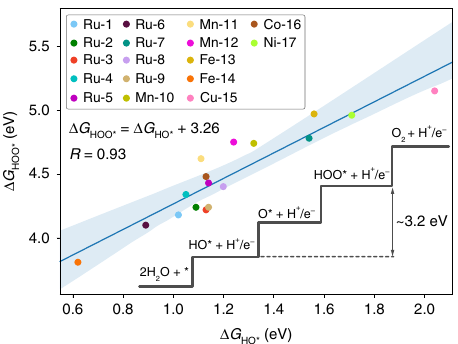
Fig. 3 Linear scaling relation between the HO ∗ and HOO ∗ intermediates for the molecular OER catalysts investigated in this work and depicted in Fig. 2. The shaded blue region represents a 99% con fi dence interval for the linear